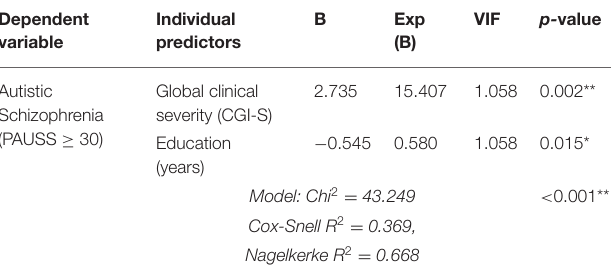
TABLE 4 | Individual predictors of autistic